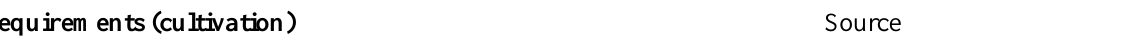
Table A1. Requirements of the pharmaceutical industry for cultivated or wild (collected in nature) Drosera raw material in central Europe.